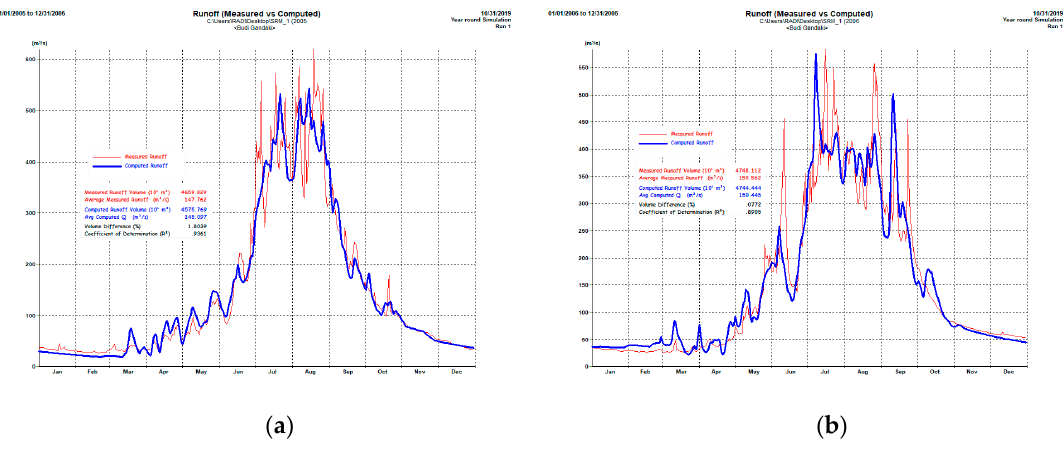
Figure 6. Simulation mode/parameter calibration for the year ( a ) 2005, and ( b ) 2006